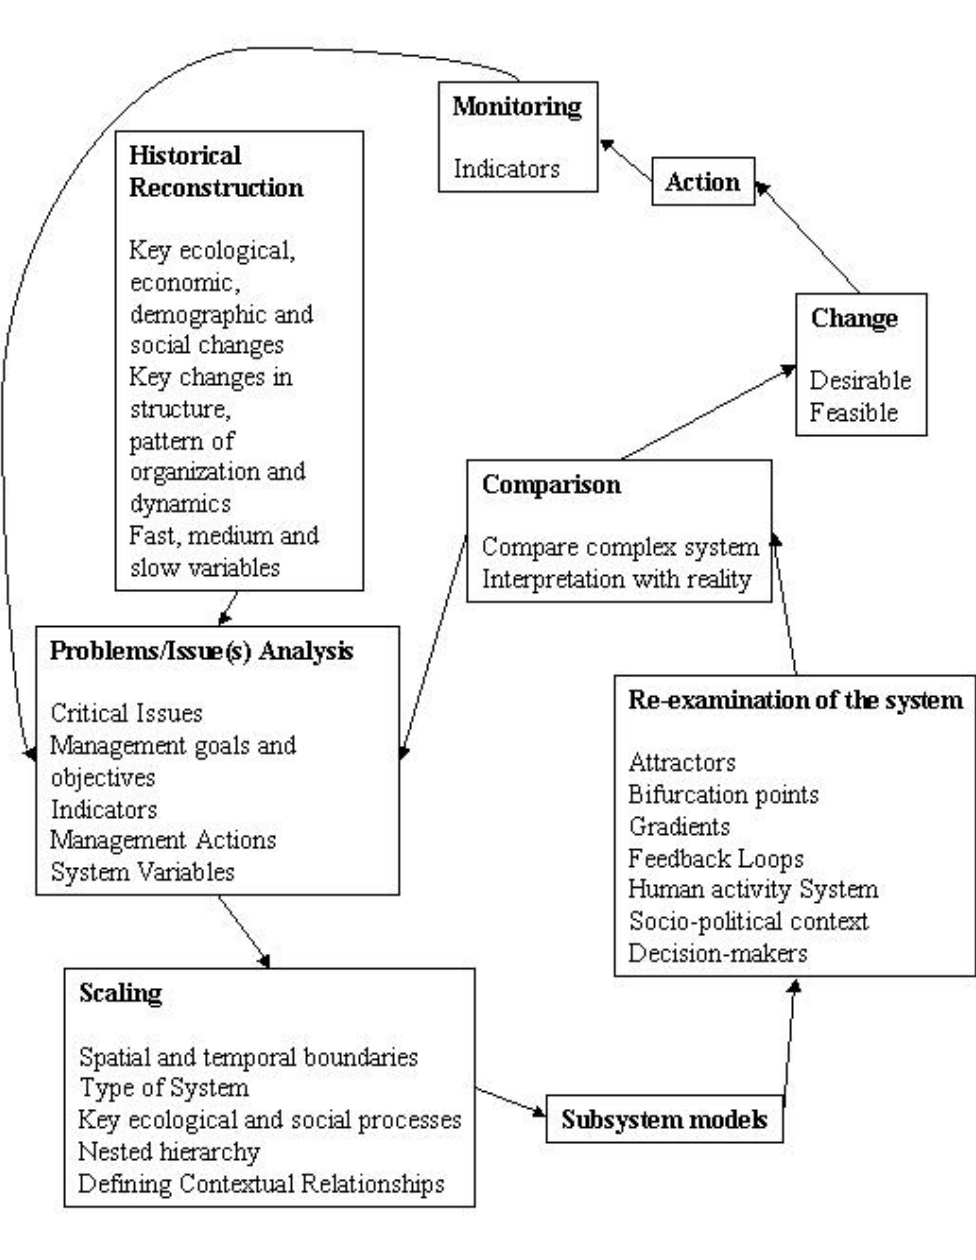
Fig. 2. An integrated conceptual framework for research into tropical agroecosystems based on complex systems theories (Rowley et al.